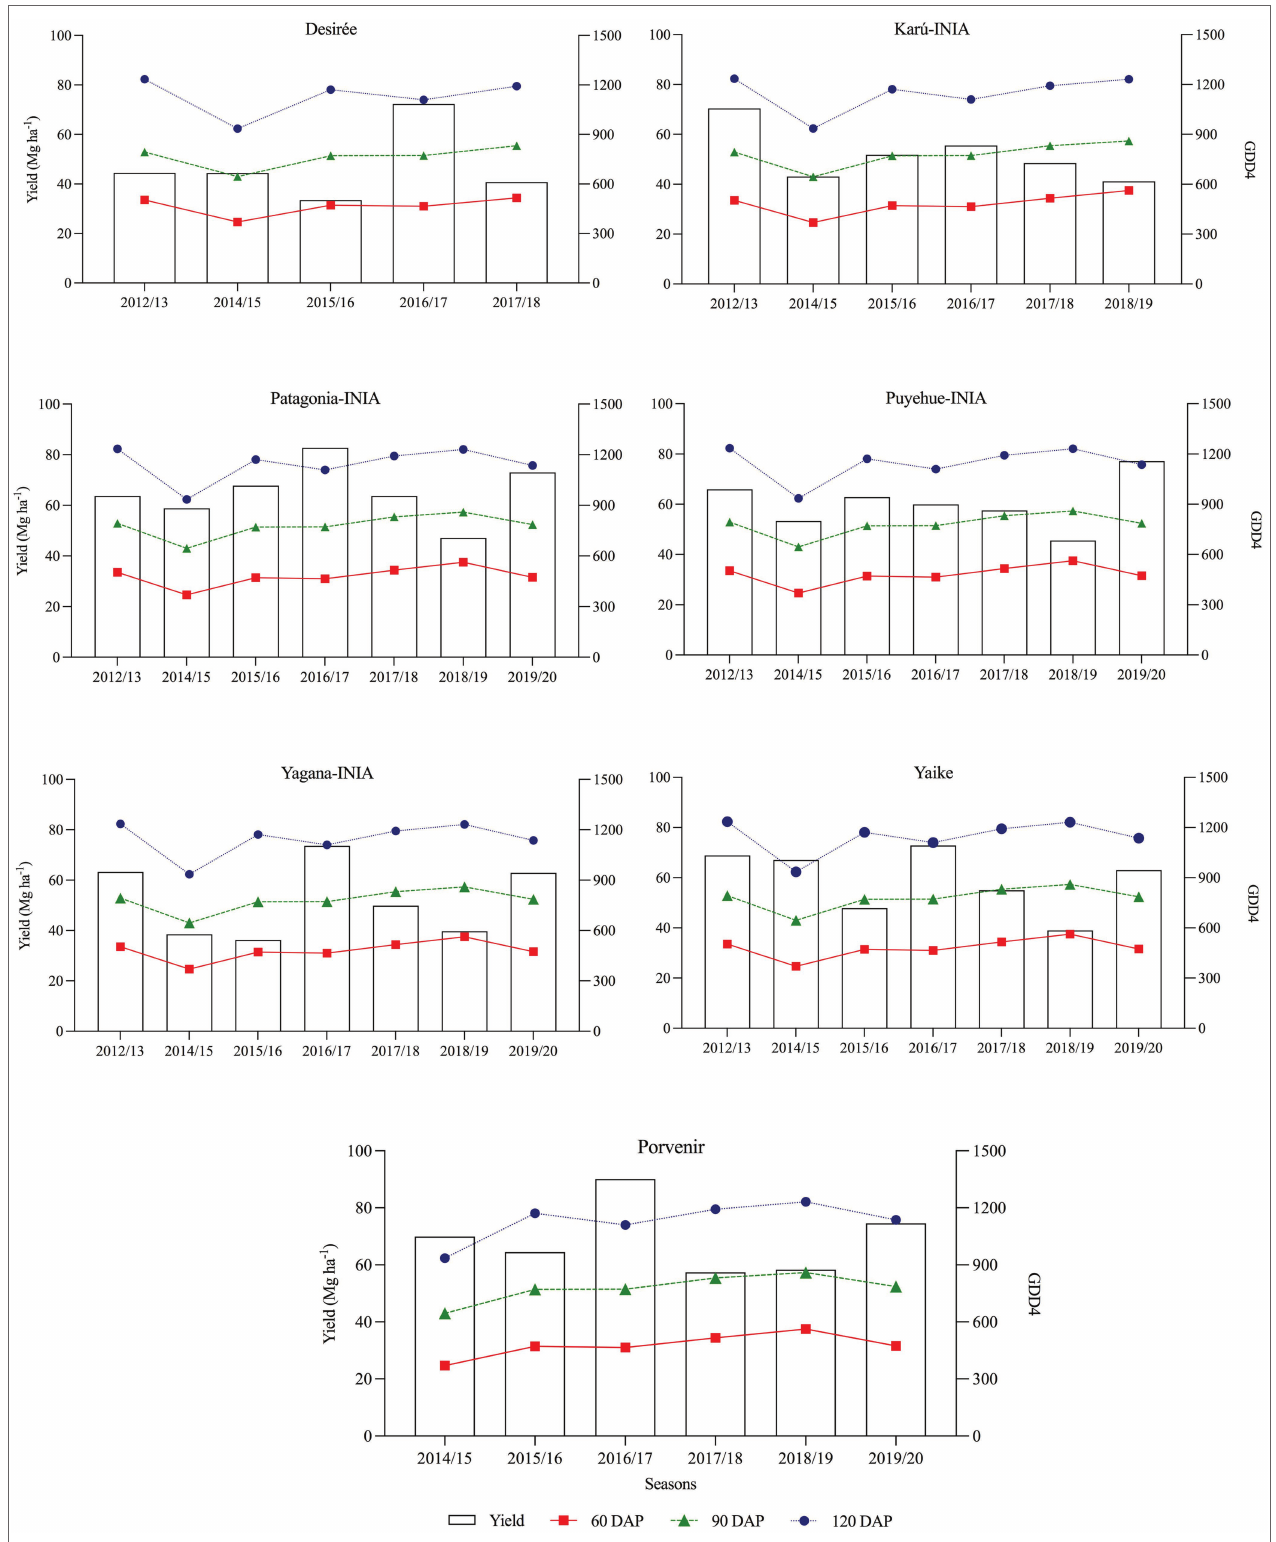
FIGURE 6 | Temporal relationship between potato tuber yield and GDD4 at 60, 90, and 120 DAP, from the 2012–13 to 2019–20 season under rainfed conditions. 60 DAP: 0–60 days, 90 DAP:60–90 days, and 120 DAP: 90–120